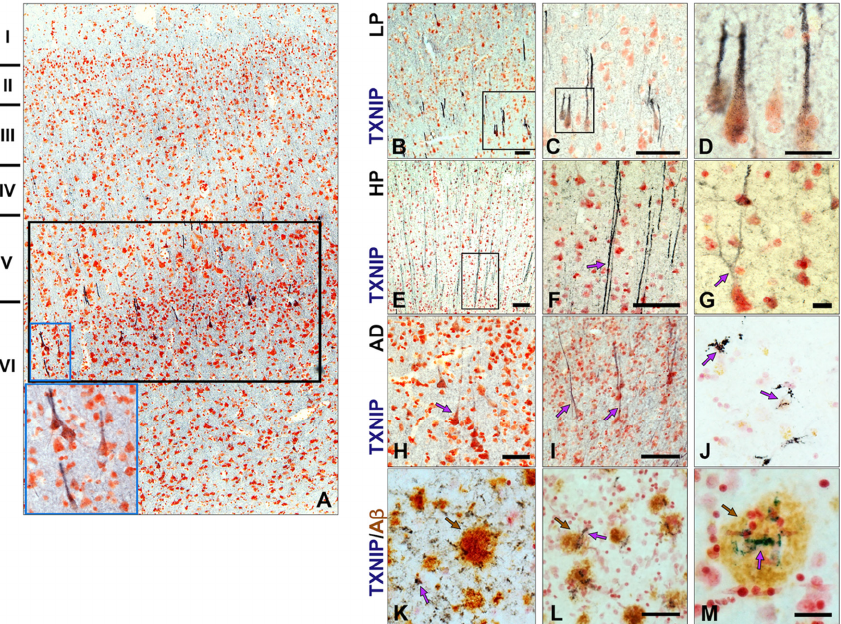
Figure 4. Distribution of TXNIP immunoreactive structures in middle temporal gyrus of LP, HP, and AD cases and in relation to A β plaques. ( A ) Low-magnification image of LP case showing selective distribution of TXNIP immunoreactive structures (purple) primarily in layer V and VI (black outline). High magnification inset showing layer VI cell structure (blue outline). ( B – D ) Progressively increasing magnification of TXNIP immunoreactive structures (purple) in a low-plaque (LP) case. ( E – G ) Different structures showing TXNIP immunoreactivity in high-plaque (HP) cases. ( H – M ) TXNIP immunoreactive structures in AD cases. ( H – I ). Weaker TXNIP staining of neuronal structures in AD cases. ( J ) Identification of microglia-like TXNIP immunoreactive cells (purple arrow). ( K – M ) Identification of microglia-like TXNIP immunoreactive cells (purple arrow) associated with A β plaques (brown arrow) in AD cases. TXNIP immunoreactivity is shown in purple color. A β immunoreactivity is shown in brown. Abbreviations: LP, low plaque; HP, high plaque; AD, Alzheimer’s disease. Bars represent 50 μ m.